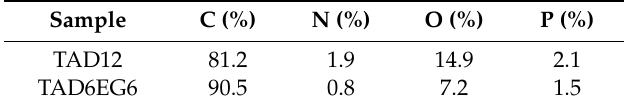
Table 4. Elemental content of char residues from cone calorimeter test obtained via